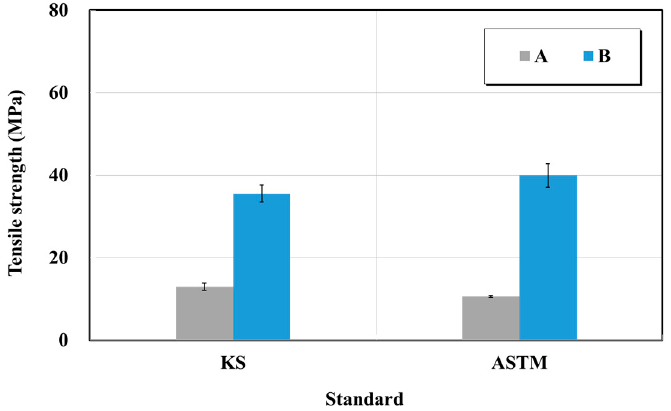
Figure 15. Tensile strength test results of crack-injection materials (epoxy resin) based on the KS and ASTM standards.